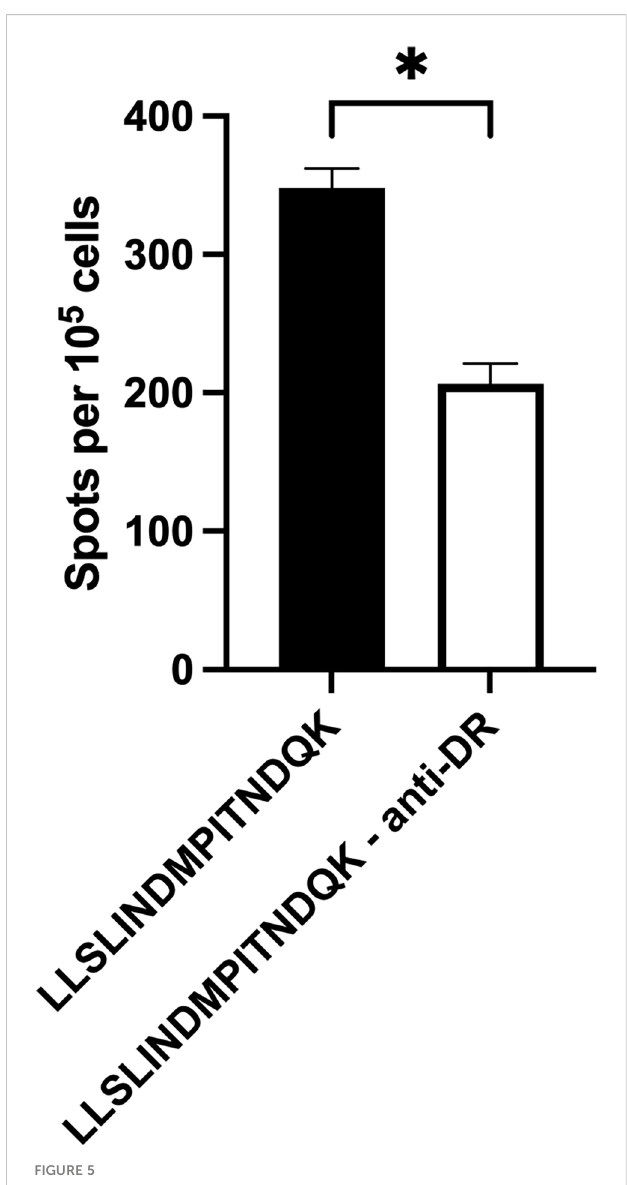
FIGURE 5 Inhibition of BoLA DR signi fi cantly reduces T cell activation. Arti fi cial antigen presenting cells incubated with anti-BoLA DR antibody signi fi cantly reduced the number of T cells responding to BRSV-375 F protein peptide. Peptide 4 sequence: LLSLINDMPITNDQK. Data presented as mean ± SEM. Statistical signi fi cance was determined using the Mann- Whitney nonparametric test, P < 0.05 indicated by